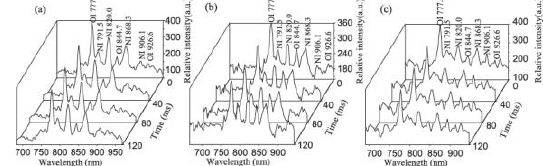
Figure3. The spectrogram of a discharge channel at a